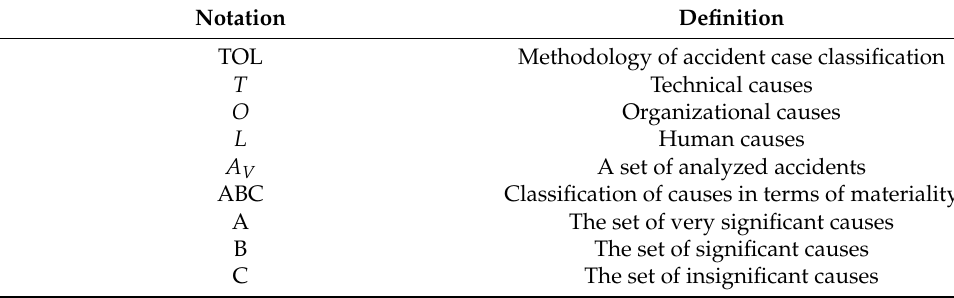
Table 1. Table of notations used in this paper.